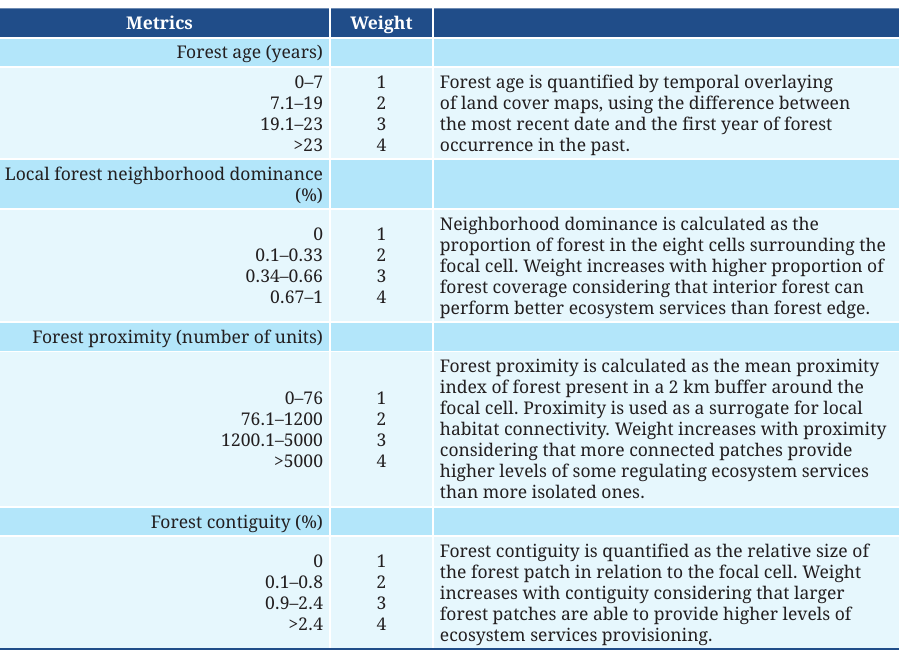
TABLE 2 | Metrics used to estimate forest quality ranking based on landscape and forest patch structure (Ferraz et al ., 2014).